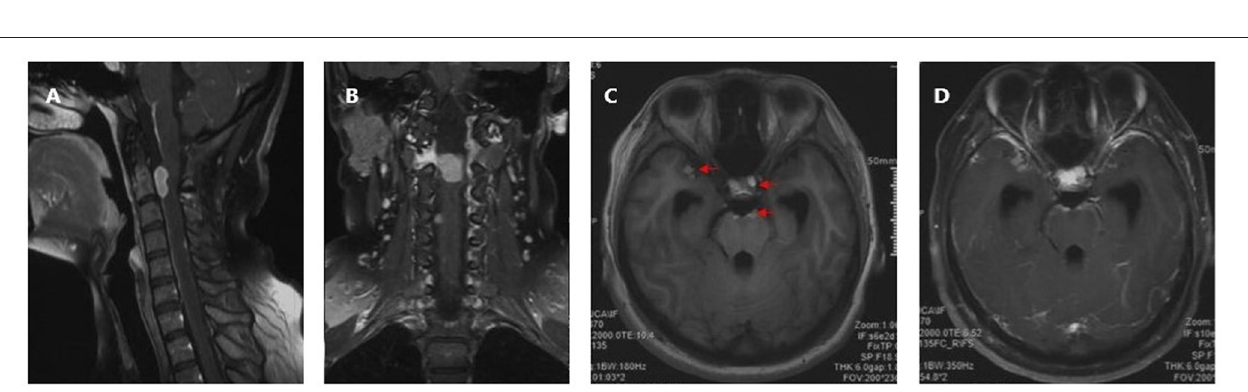
FIGURE 4 | Pathology of the lesion resected during the first surgery. (A) Hematoxylin and eosin staining (x100). (B) Hematoxylin and eosin staining (x400). (C) Ki-67 immunostaining (x400). (D) Tumor pial junction (x100). (E) Tumor dural junction (x100).